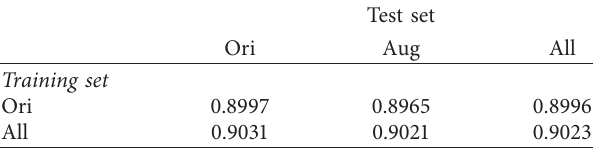
Table 5: Test results before and after